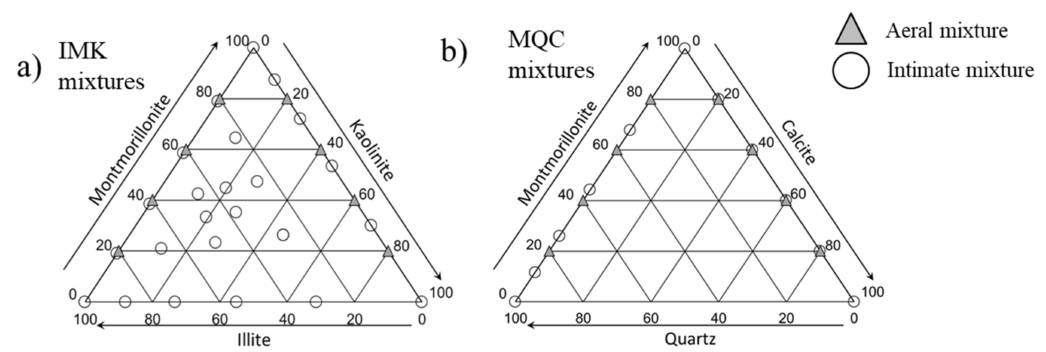
Figure 4. Ternary diagrams of ( a ) clay mixtures and ( b ) montmorillonite–quartz / calcite mixtures (unit: wt %).